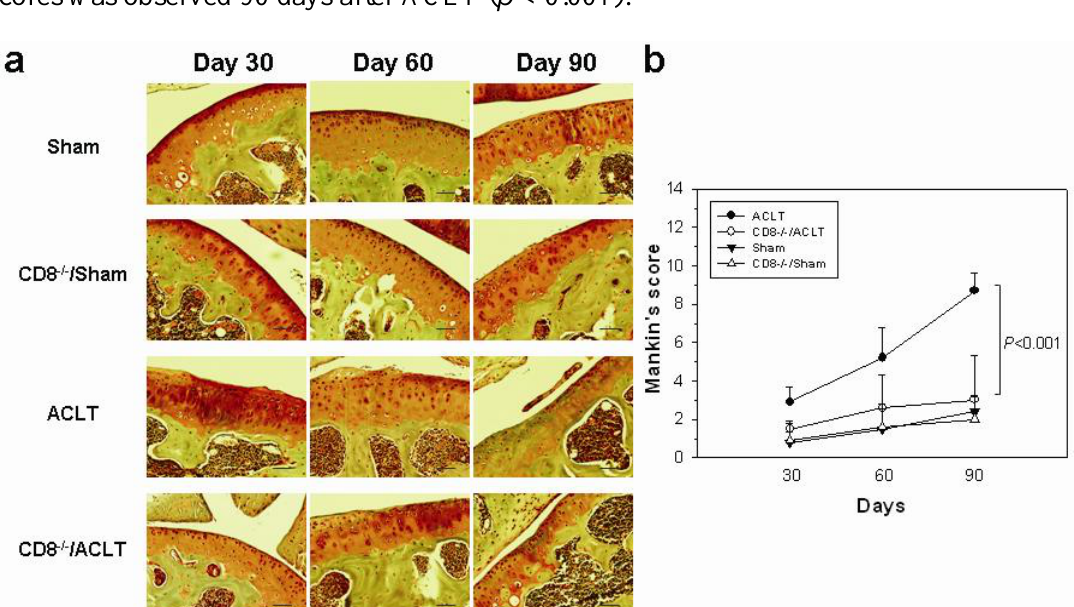
normal. The mean synovitis score in the joints of CD8 −/− /ACLT-group mice was significantly lower than that in the joints of ACLT mice 90 days after OA induction ( p = 0.0004) (Figure 1d). The intra class coefficients of both scores used for evaluating interobserver’s variation at day 30, 60, and 90 were 0.64, 0.88, and 0.97, respectively, p < 0.001. Figure 1. Evaluation of histological changes in the knee joints of anterior cruciate ligament-transection (ACLT)-induced osteoarthritis (OA). The mice were divided into groups by those not subjected to ACLT (Sham-group and CD8 −/− /Sham group) and those that were subjected to ACLT (ACLT-group and CD8 −/− /ACLT group). The histological changes at day 30, 60, and 90 after ACLT were analyzed. Cartilages from the medial femoral condyle are shown. ( a ) Representative sections of cartilage which scores were the most close to the means in each group were shown (Safranin-O/fast green stain; 200× magnification; scale bar = 50 µm); ( b ) Histological examination showed a significantly lower Mankin’s score in the joints from CD8 −/− /ACLT-group mice than in those from ACLT-group mice on day 90; ( c ) Representative sections of synovium which scores were the most close to the means in each group were shown (hematoxylin and eosin stain; 200× magnification; scale bar = 50 µm); and ( d ) Histological examination showed a significantly lower synovitis score in the joints from the CD8 −/− /ACLT-group mice on day 90. Data are means ± 95% confidence intervals ( n = 5 per group). Significant difference in scores was observed 90 days after ACLT ( p <